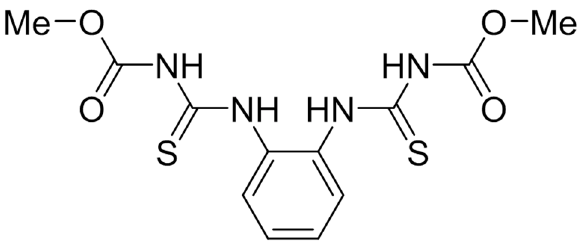
Figure 1. The chemical structure of thiophanate methyl.